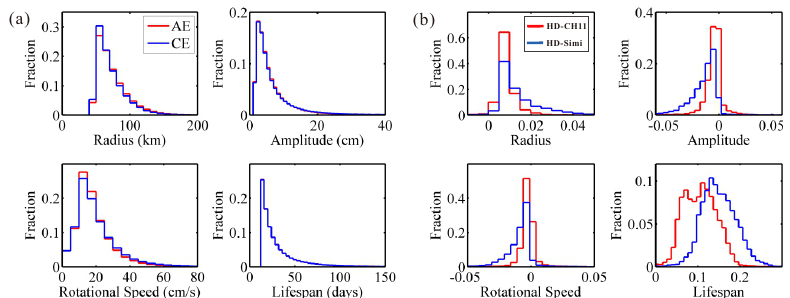
Figure 12. ( a ) Global eddy statistics for cyclonic (CE) and anticyclonic (AE) eddies tracked by the hybrid method; ( b ) Relative difference between the hybrid and CH11 methods and the hybrid and similarity